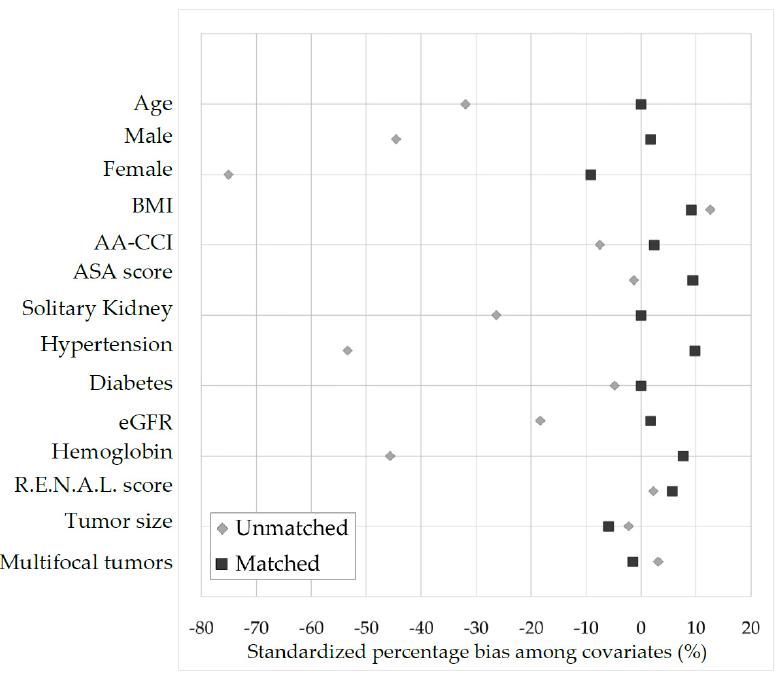
Figure 3. Covariate balance between OPN and RAPN patients using standardized percentage bias across covariates.